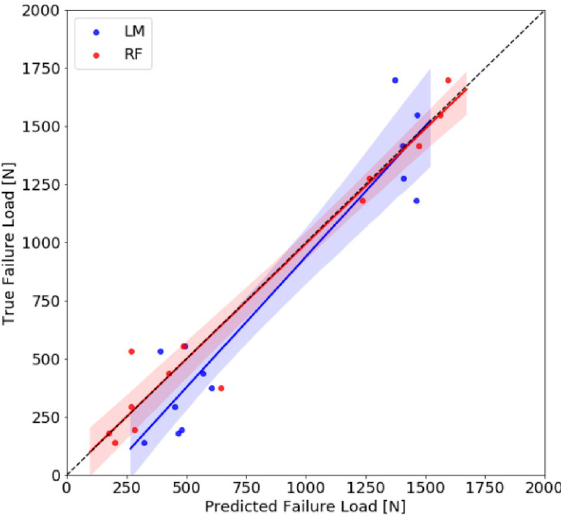
Figure 2. Comparison of test set predictions to ground truth failure load in Newtons (N) for best machine learning model, random forest (RF), and benchmark linear model (LM) in the porcine model. The shaded regions represent the 95% confidence intervals.